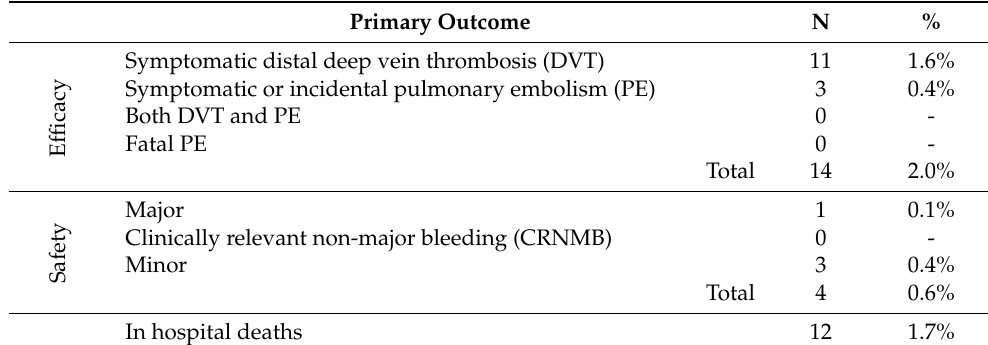
Table 2. Primary outcomes of INTERACT